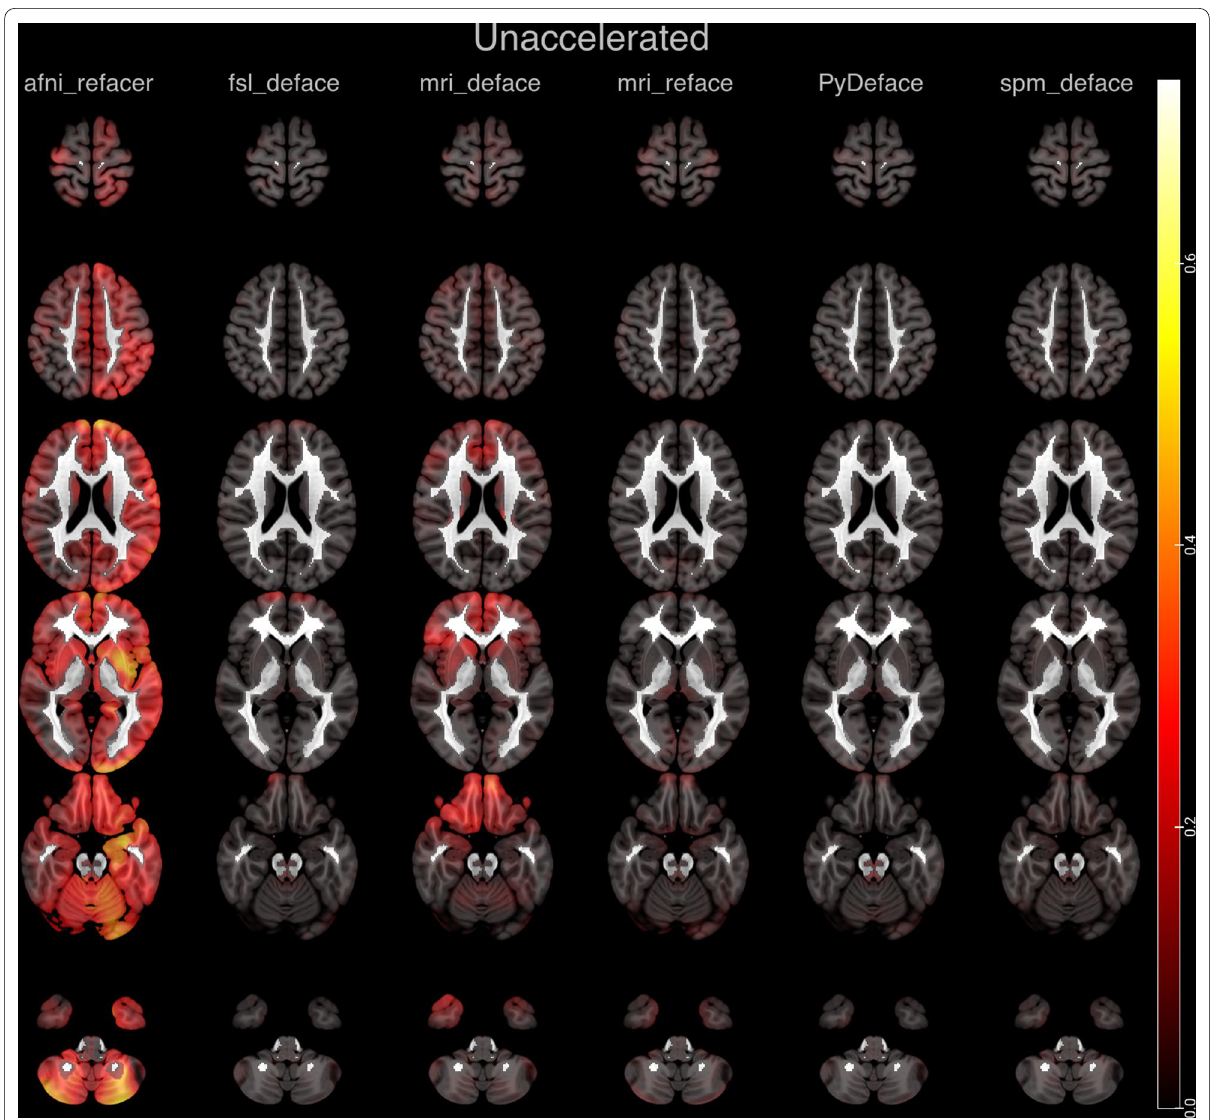
Fig. 3 Absolute mean differences of the z-scores plotted as a heat map onto representative axial slices of the SPM152 standard template after applying the different defacing approaches on unaccelerated